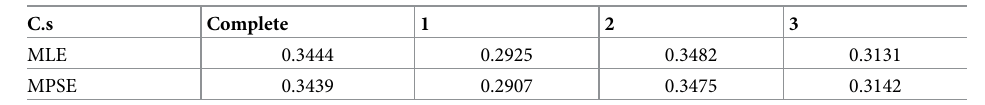
Table 19. Estimates of θ for example